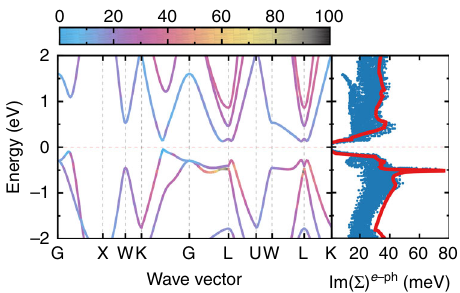
Fig. 4 Electron – phonon coupling. Heat map of the imaginary part of the electron – phonon self-energy (Im( Σ )) of Li 2 TlBi at 300 K (left) and mode- dependent Im( Σ ) compared with scaled density of states (DOS)